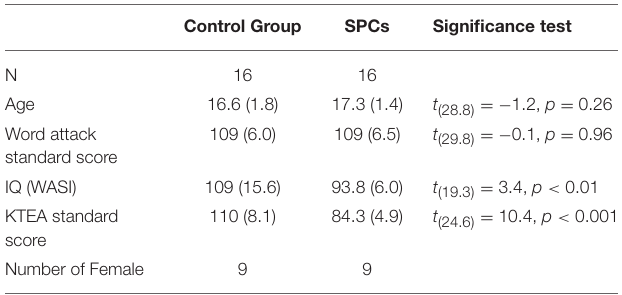
TABLE 1 | Descriptive Statistics of SPCs and Controls, with means and standard deviations in parenthesis.